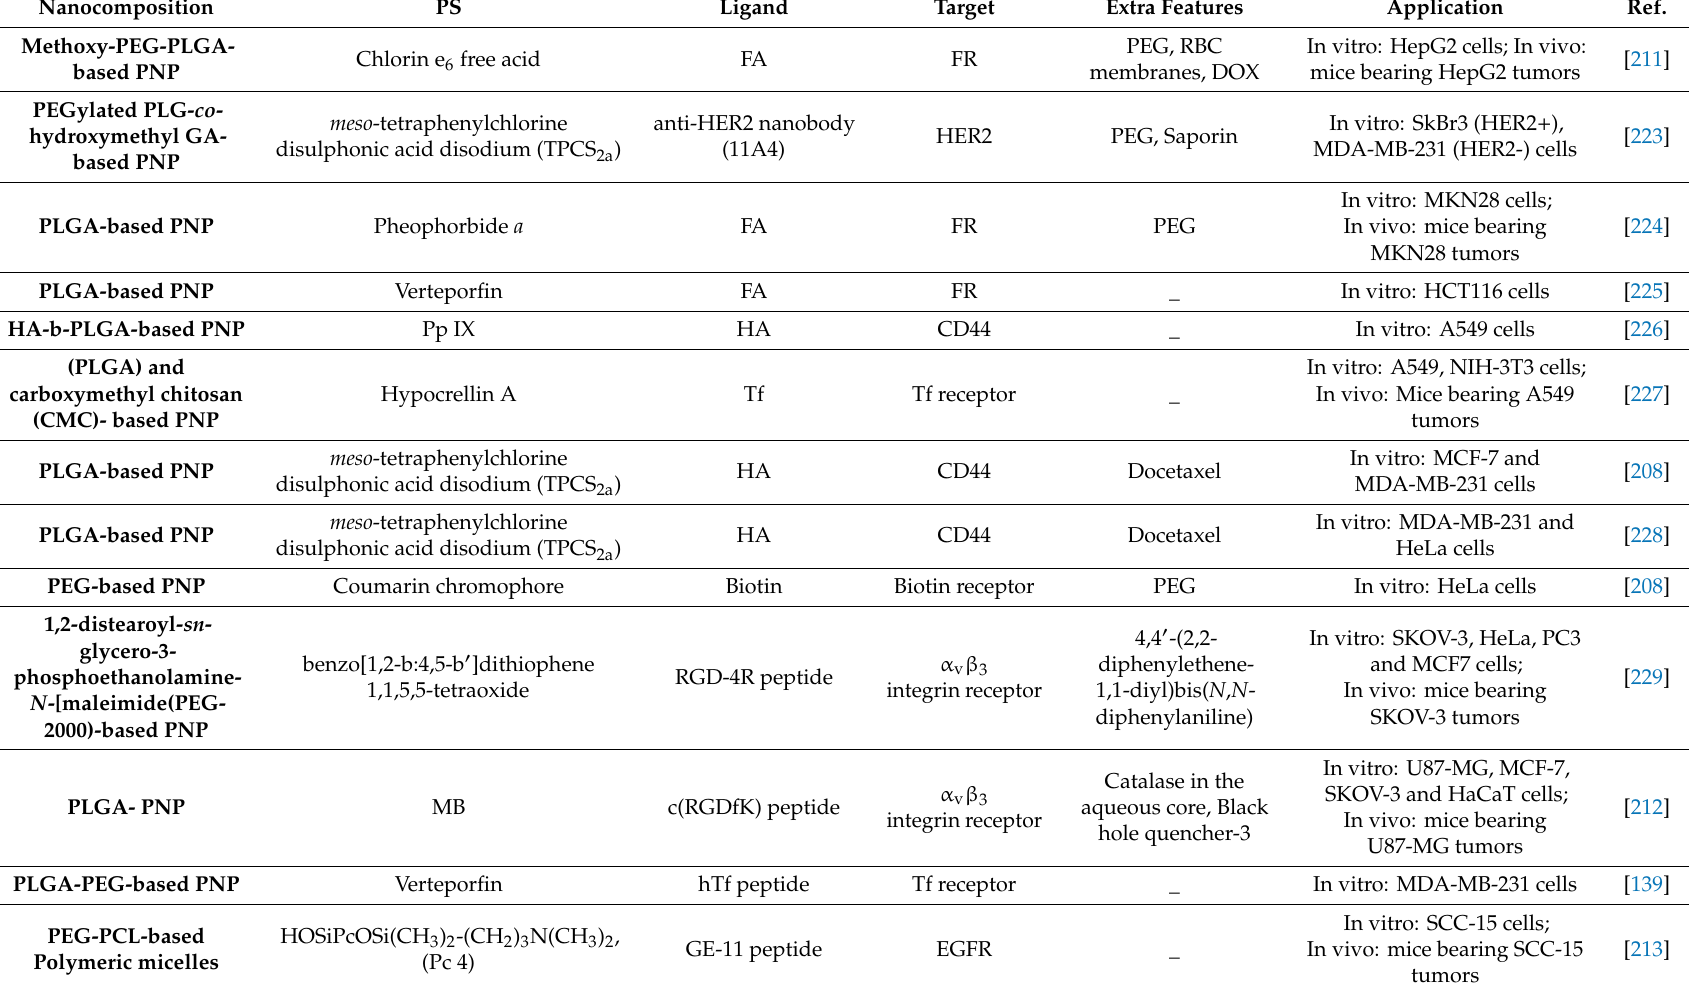
Table 5. Examples of ligand-targeted polymer-based NPs for